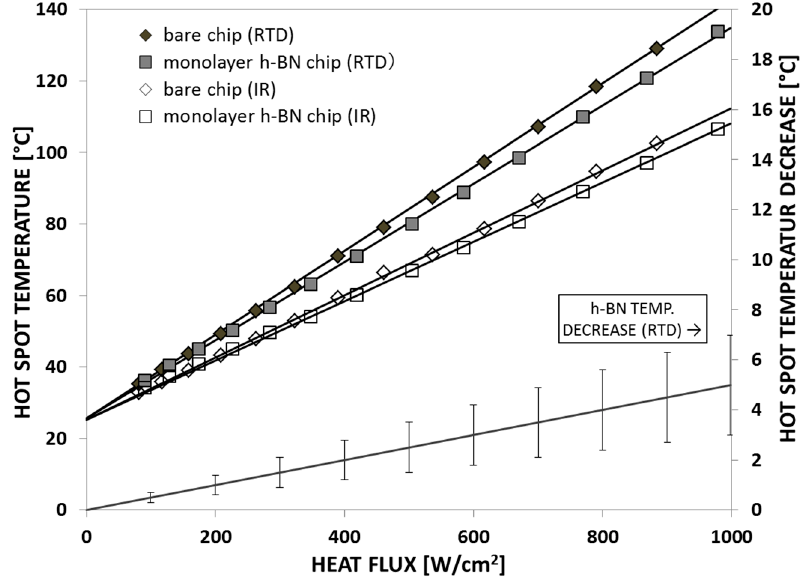
Figure 15. Cooling efficiency of the single-layer hBN heat spreader. Replotted data sourced from Reference [47].